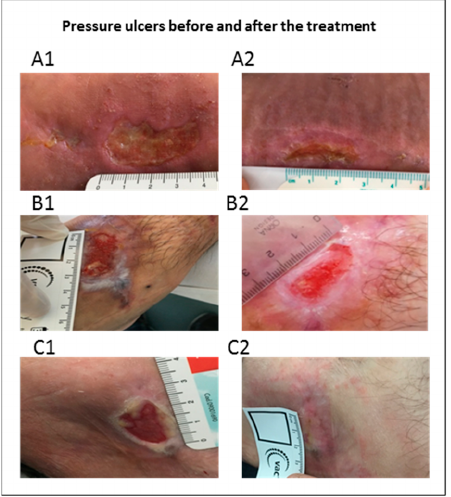
Figure 2. Images of pressure ulcers before (A1, B1, C1) and after 30 days of treatment with chitosan gel (A2, B2, C2).